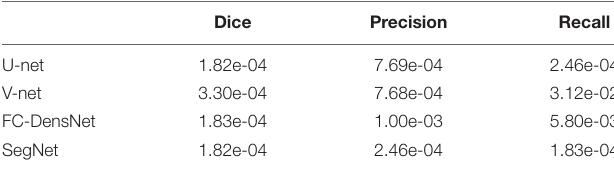
TABLE 4 | P -values of Wilcoxson test among DeepBrainSeg and other